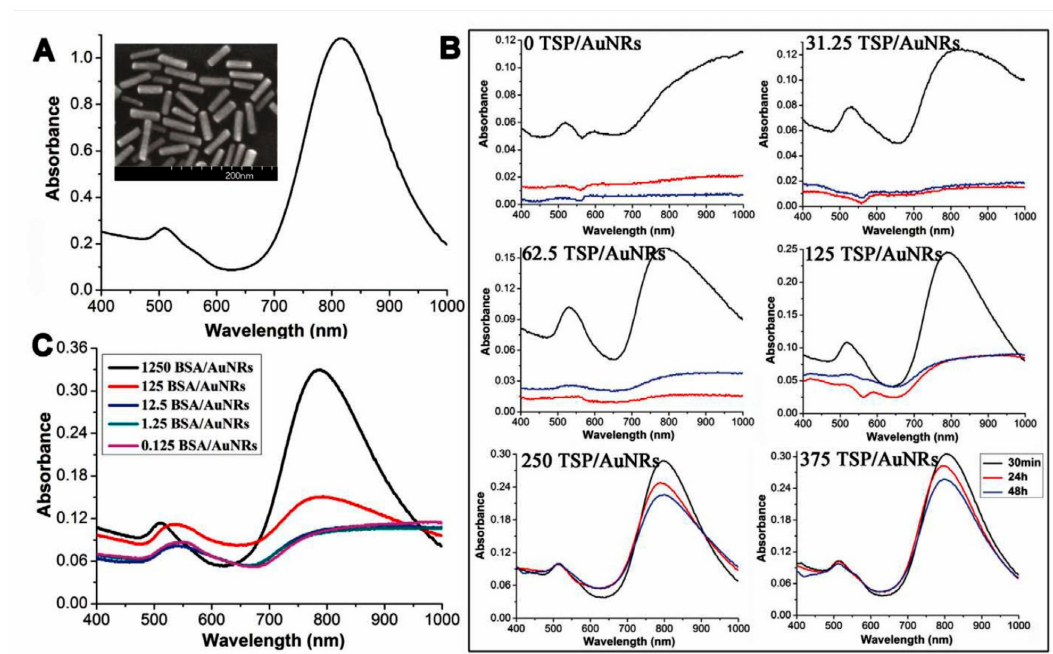
Figure 4. UV-vis-NIR spectrum of AuNRs suspension in water ( A ). Spectra of gold nanorods (AuNRs) dispersed in serum containing media (SCM) with 0–30% of fetal bovine serum (FBS) and di ff erent incubation times ( B ). Spectra of bovine serum albumin (BSA) / AuNRs samples ( C ). Reproduced in agreement with CC BY 4.0 license from Ref.